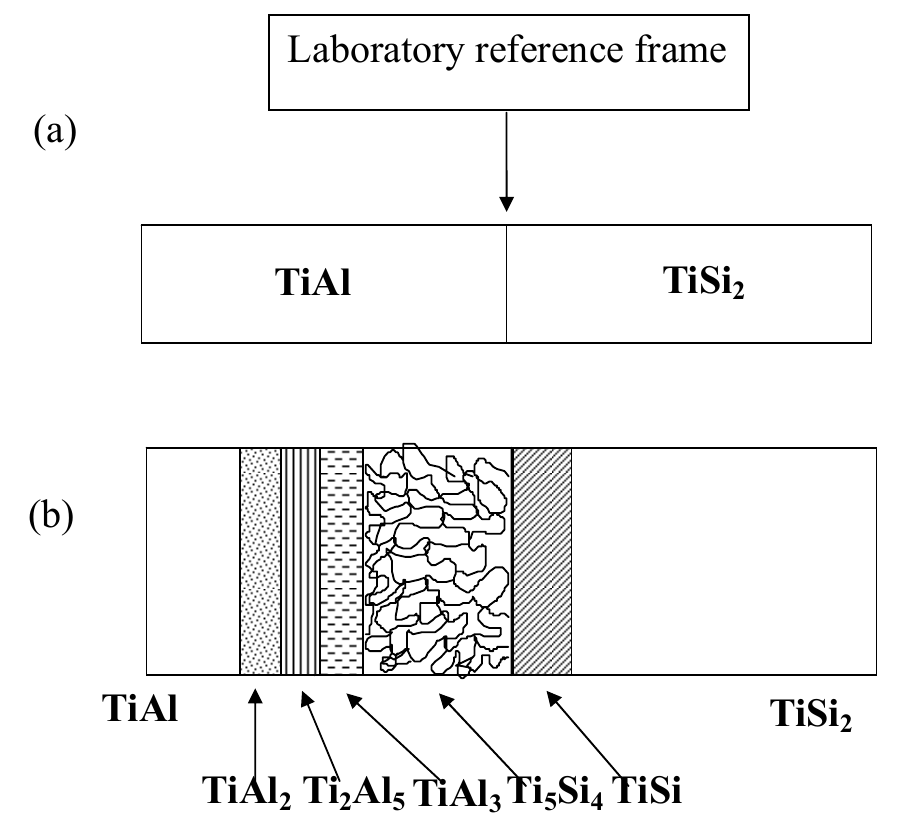
Figure 14. The schematic illustration of the reaction products and the placement of the laboratory reference frame (not put to a scale) (a) before reaction, (b) after